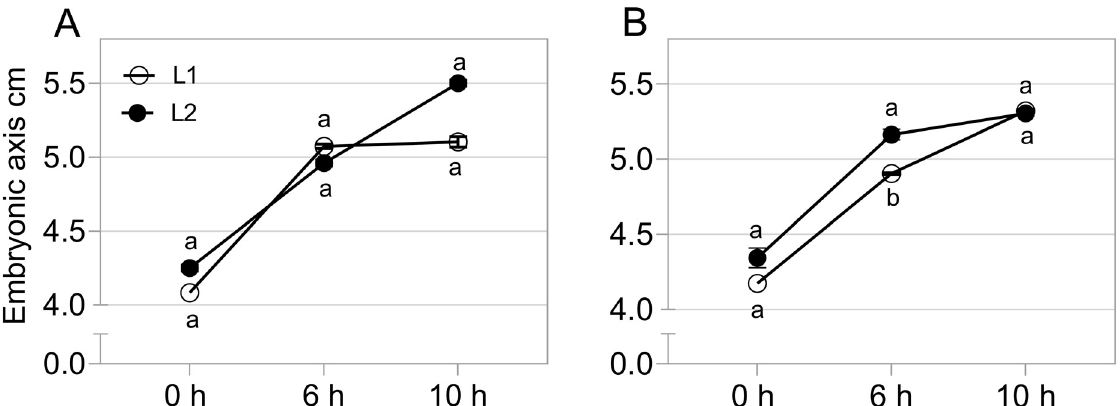
Figure 4. Embryonic axis length during germination in two commercial cultivars (A: cv1-BRS133 and B: cv2-MG/BR 46 (Conquista)) and their respective seed lots (L1: lot 1 and L2: lot 2) during germination sensu stricto . cv1 ( A ) and cv2 ( B ) at 0 h, 6 h and 10 h of germination. Distinct letters in each point of evaluation indicate a significant difference at the 5% probability level ( p < 0.05). Error bars show standard deviation ( n = 6).